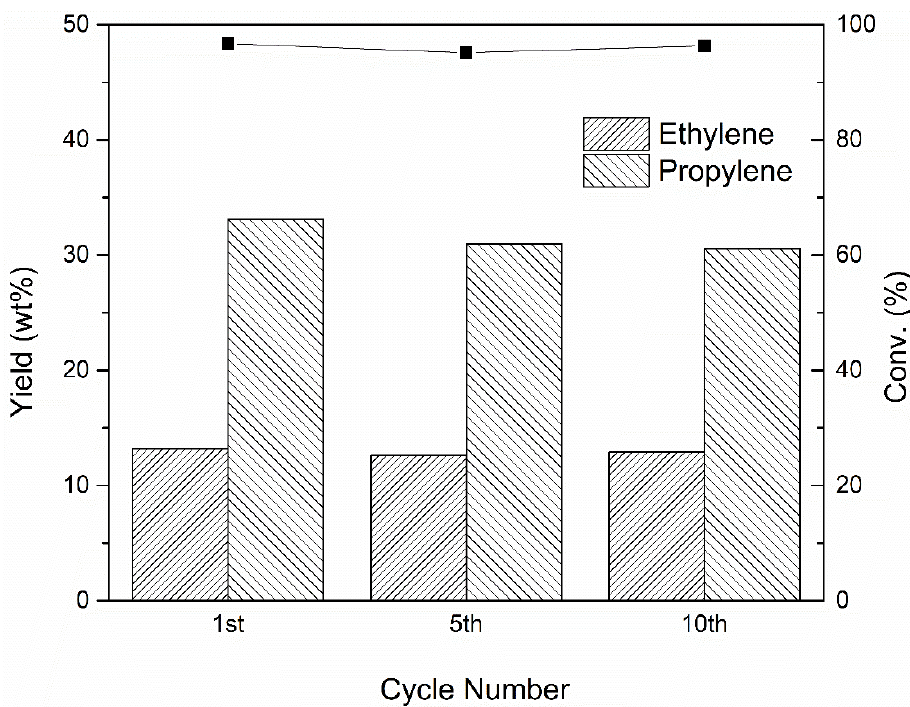
Figure 7. n -Octane conversion and yields of ethylene and propylene over 10